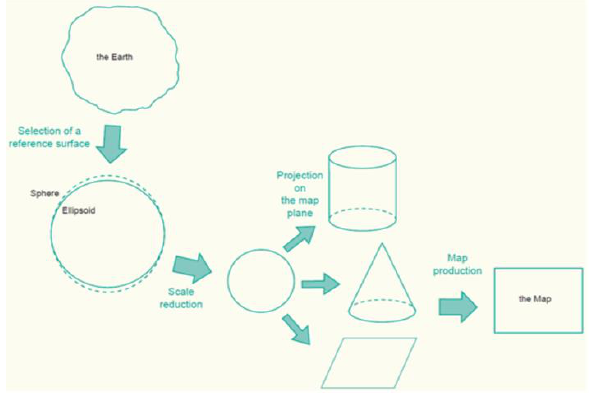
Figure 14. The Process of Representing the Earth on a Flat Map (Source: Geometric Aspect of Mapping, R. Knippers,